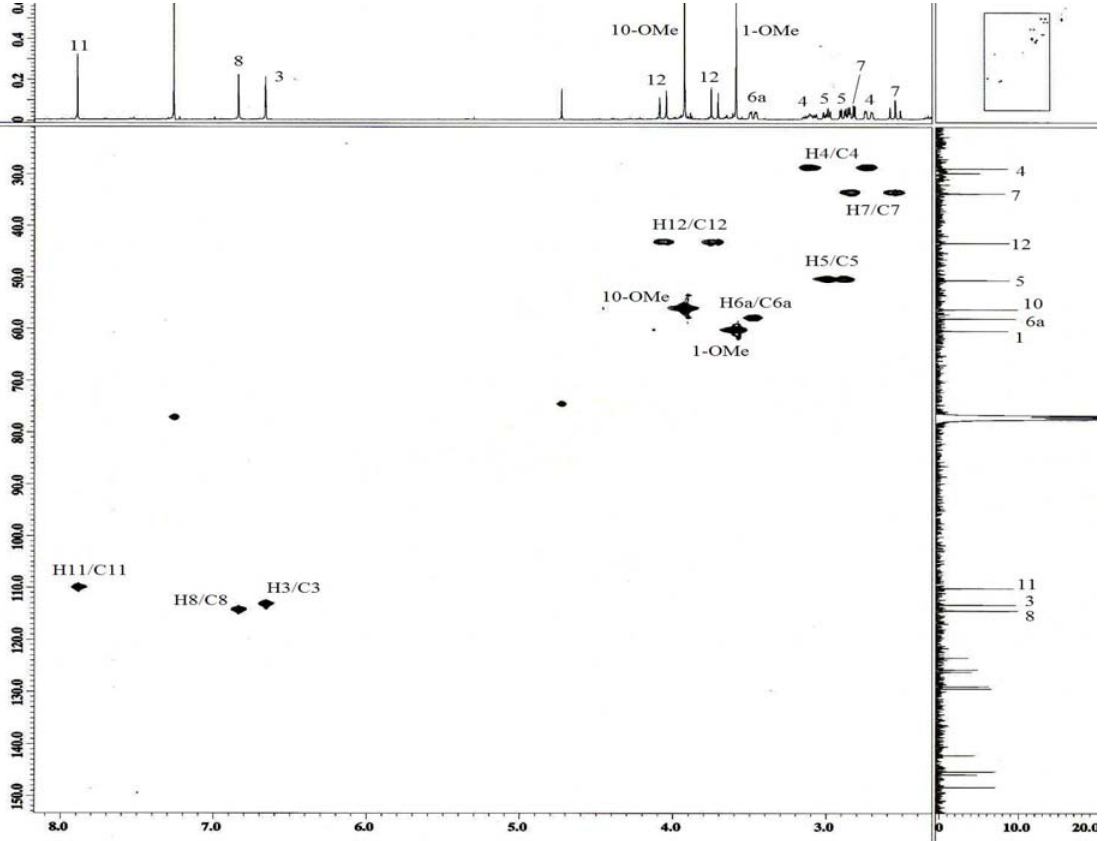
Figure 7. HSQC-NMR spectrum of alkaloid 1